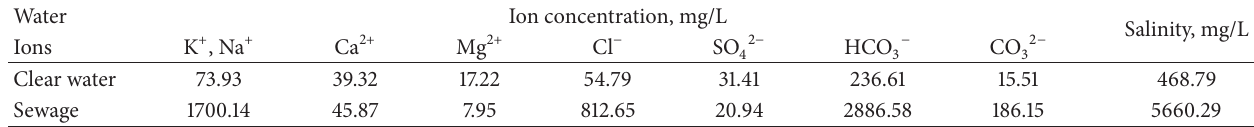
Table 1: The ionic composition of experimental water